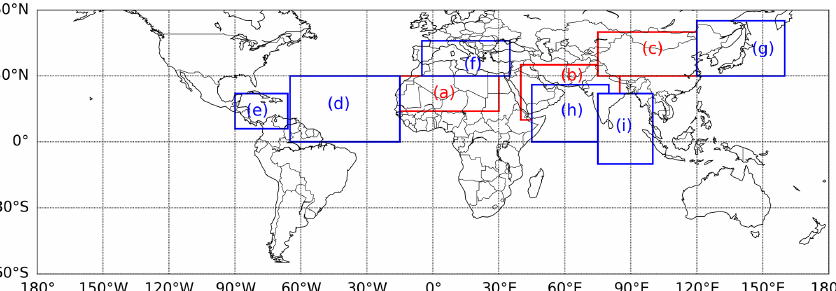
Figure 8. Major dust-laden regions including three dust source regions on land (a–c) and six outflow regions over the ocean (e–i) . (a) Sahara (14–30 ◦ N, 15 ◦ W–30 ◦ E), (b) Middle East (10–35 ◦ N, 40–85 ◦ E), (c) eastern Asia (30–50 ◦ N, 75–130 ◦ E), (d) the tropical Atlantic Ocean – TAT (0–30 ◦ N, 15–60 ◦ W), (e) the Caribbean Sea – CRB (6–22 ◦ N, 60–90 ◦ W), (f) the Mediterranean Sea – MED (30–46 ◦ N, 5 ◦ W–35 ◦ E), (g) the northwest Pacific Ocean – NWP (30–55 ◦ N, 120–160 ◦ E), (h) the Arabian Sea – ARB (0–26 ◦ N, 45–80 ◦ E), and (i) the tropical Indian Ocean and the Bay of Bengal – IND (10 ◦ S–22 ◦ N, 75–100 ◦ E). Note that we only consider grids over land for the three dust source regions and grids over the ocean for the six dust outflow regions.